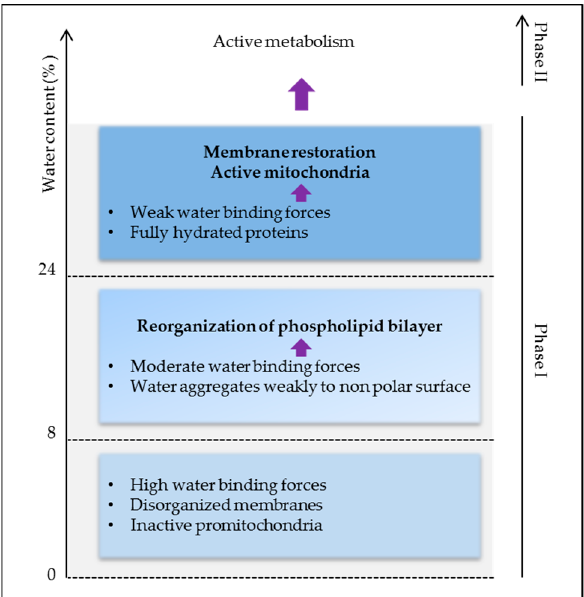
Figure 3. Early cellular events during imbibition as related to water binding forces.